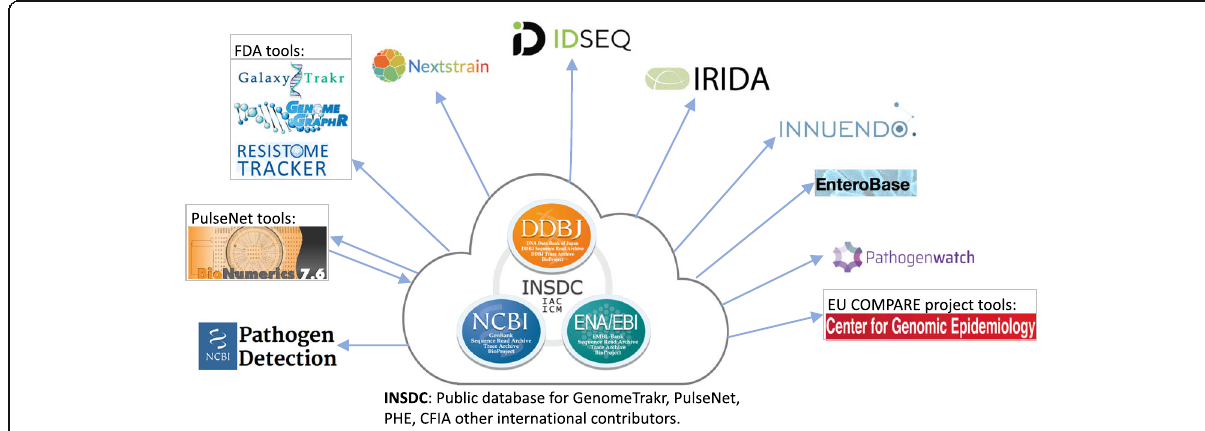
Fig. 1 INSDC hub showing how genomic data in public databases get analyzed by many different software platforms, for different purposes. Included in this figure are most genomic epidemiology-related open source analysis platforms available in March of 2020, and one private software tool, BioNumerics. BioNumerics is also the only platform with submission